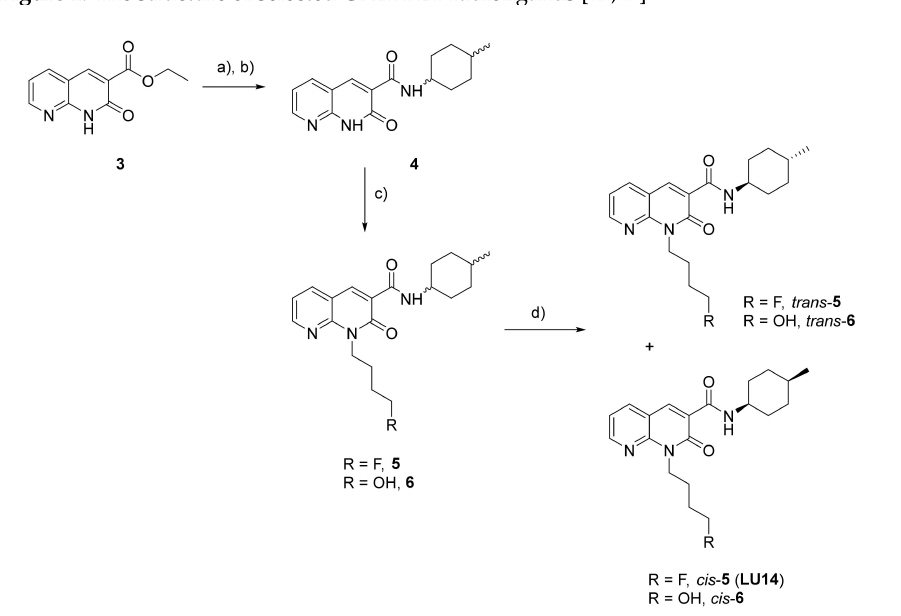
Scheme 1. Synthesis of compounds cis- and trans - 5 and 6 . Reagents and conditions: a) LiOHxH 2 O, THF/MeOH/H 2 O (2:1:1, v / v / v ), 60 ◦ C, 2.5 h; b) 4-methylcyclohexylamine, BOP, NEt 3 , DCM, 16 h, rt; c) 1-bromo-4-fluorobutane for cis - /trans - 5 and 1-bromo-4-butanol for cis - /trans - 6 , K 2 CO 3 , DMF, 90 ◦ C, 19 h; d) flash chromatography, SiO 2 eluting with EA/IH 1:9. BOP = [(1 H -benzo[ d ][1,2,3]triazol-1- yl)oxy]tris(dimethylamino)phosphonium hexafluorophosphate(V)